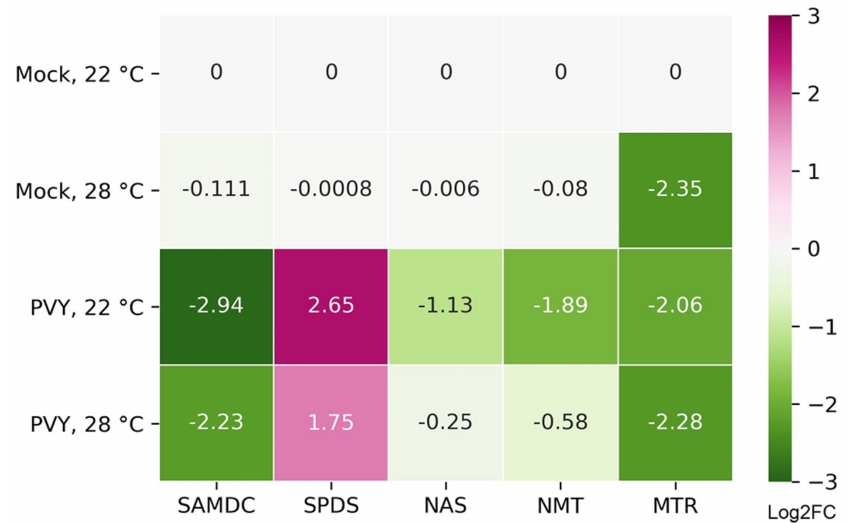
Figure 4. Heatmap showing the changes in abundance (log 2 FC) of mRNAs associated with the methionine cycle: adenosylmethionine decarboxylase (SAMDC; Soltu.DM.02G030190.1), spermidine synthase (SPDS; Soltu.DM. DM.06G014450.1), nicotianamine synthase (NAS; Soltu.DM.01G040240.1), phosphoethanolamine N-methyltransferase (NMT;